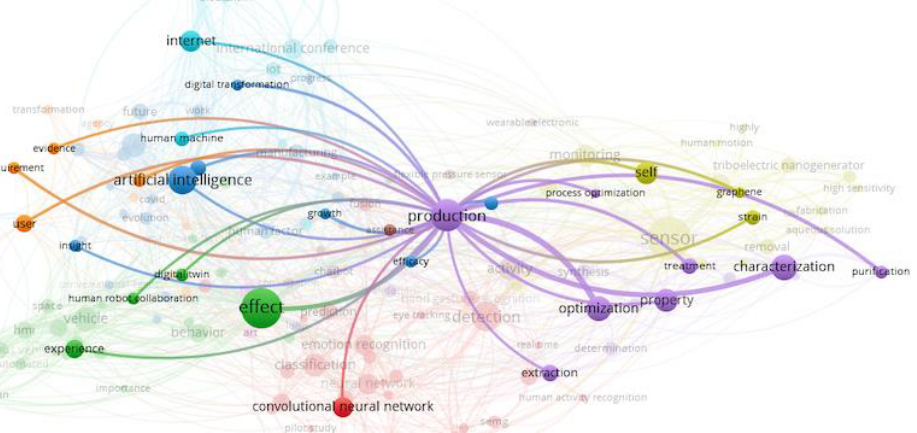
Figure 19. Production dependency.